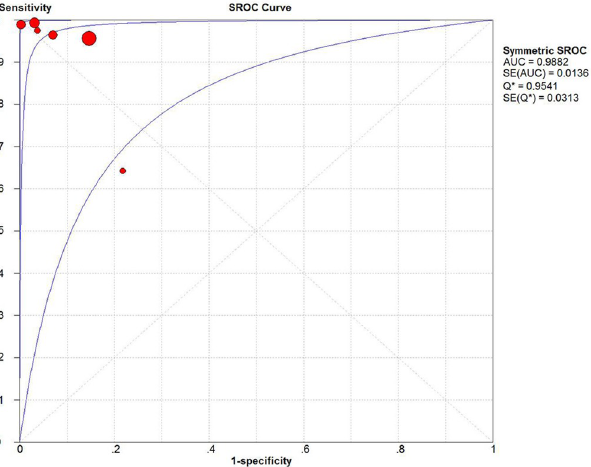
Fig 1. Summary receiver operating curves of vanA and vanB group. The SROC AUC was 0.9882, which is close to 1, indicating a high ability for VRE detection.